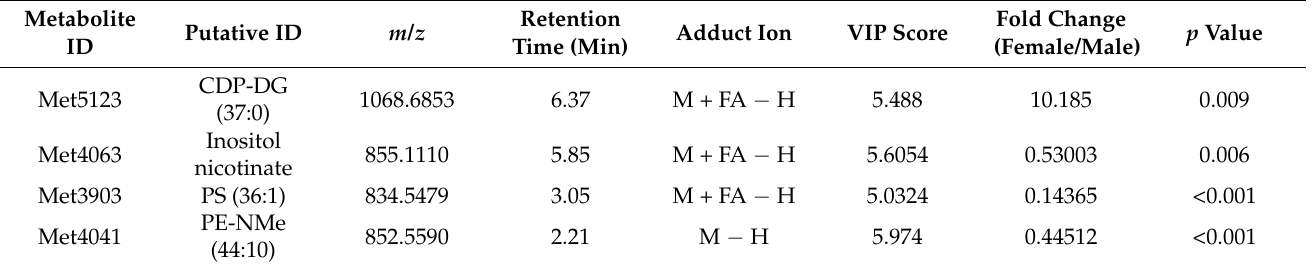
Table 7. The difference of lipidomics in MS-electrospray negative ion mode between female and male living liver